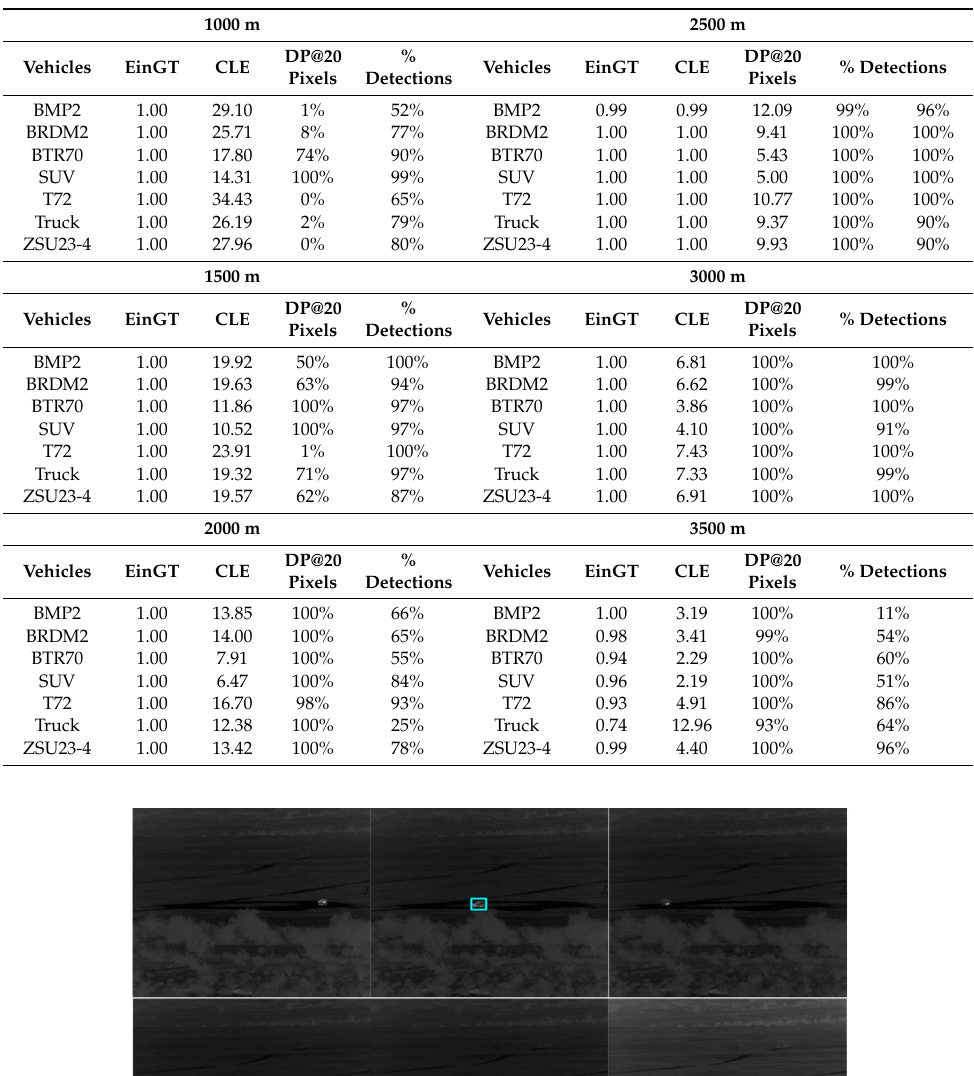
Table 8. Tracking metrics for PCE full (MWIR nighttime).